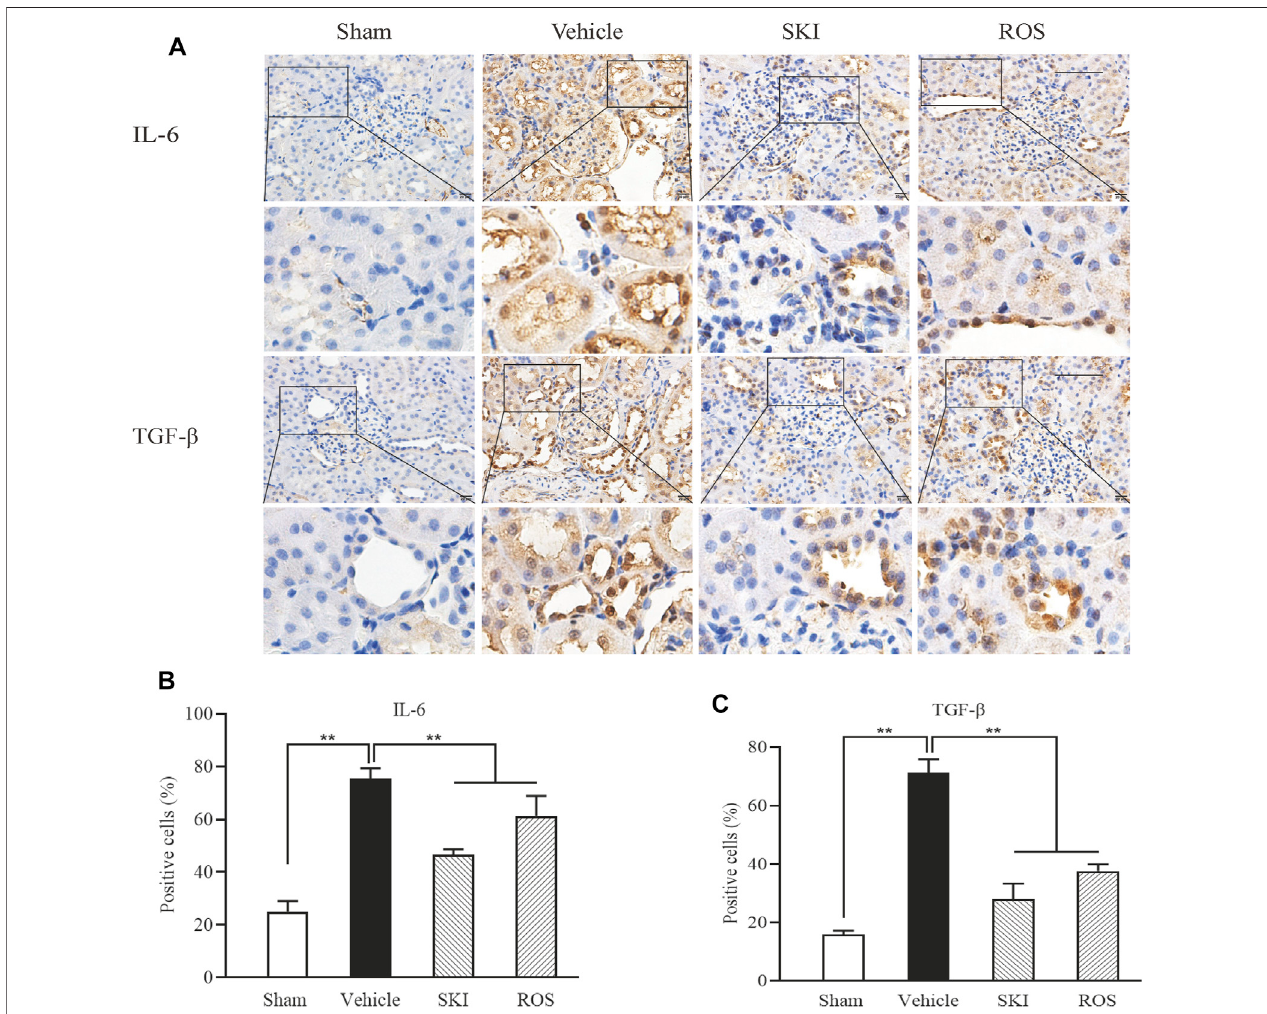
FIGURE 4 | The effects of SKI and ROS on the expression levels of IL-6 and TGF- β in vivo . (A) Immunostaining of IL-6 and TGF- β in the kidney ( × 200); (B, C) The number of positively stained cells. Scale bar (cid:2) 100 μ m. Data are expressed as mean ± S.E. ** p < 0.01. Abbreviations: IL-6, interleukin-6; TGF- β , transforming growth factor- β ; ROS, rosiglitazone; SKI, Shenkang